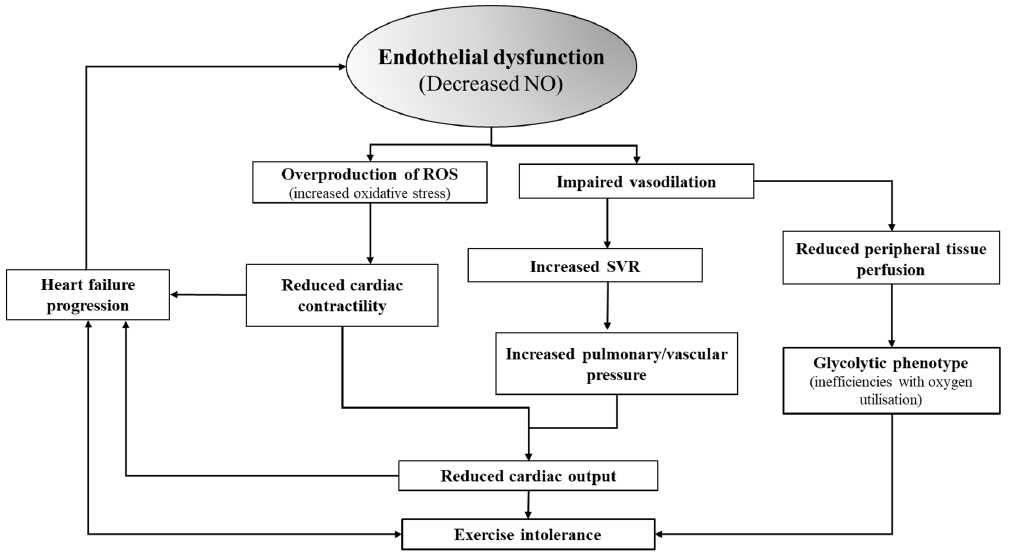
Figure 1. Role of NO in central and peripheral dysfunctions in HFrEF.